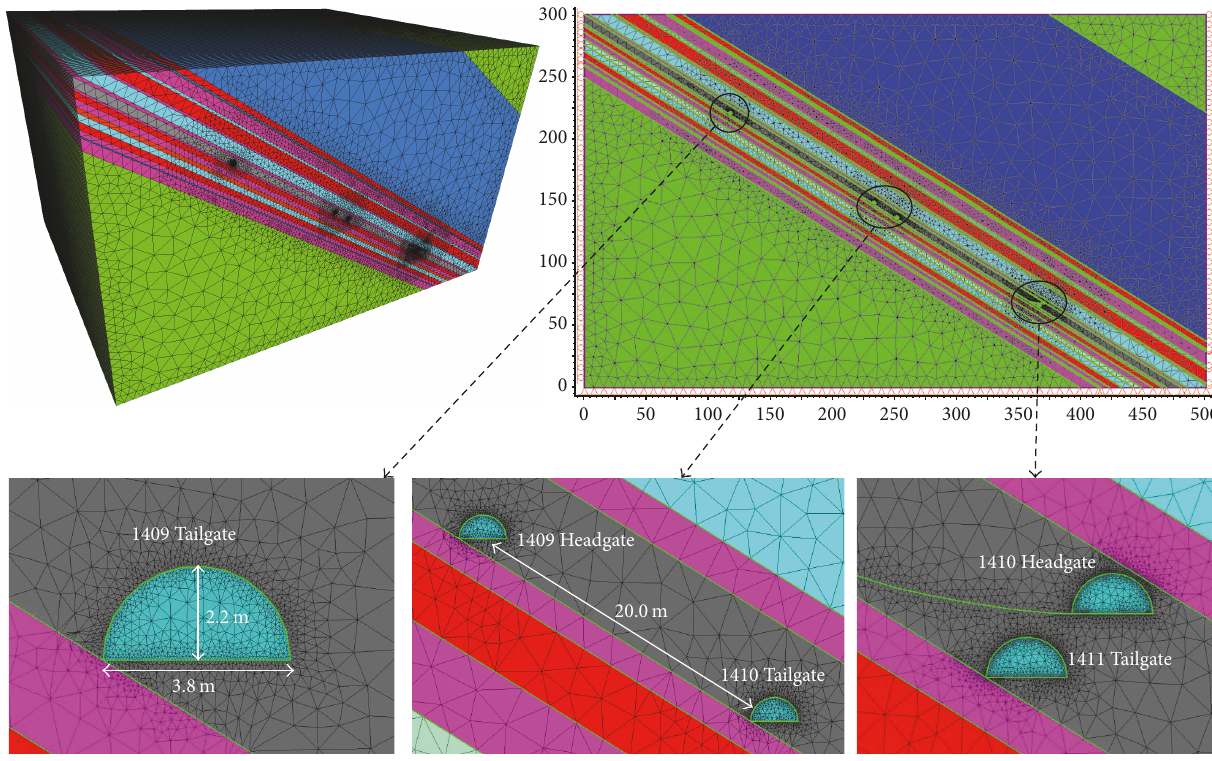
Figure 12: FLAC3D